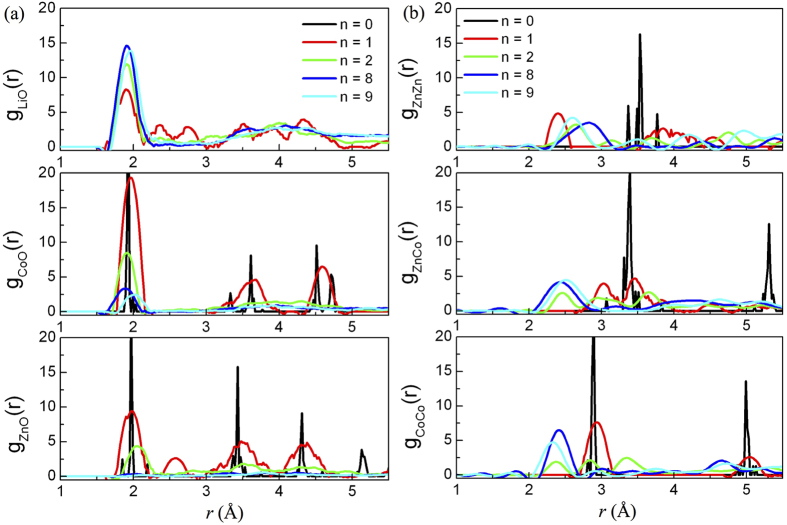
The partial pair correlation functions of LinZnCo2O4 as a function of n.